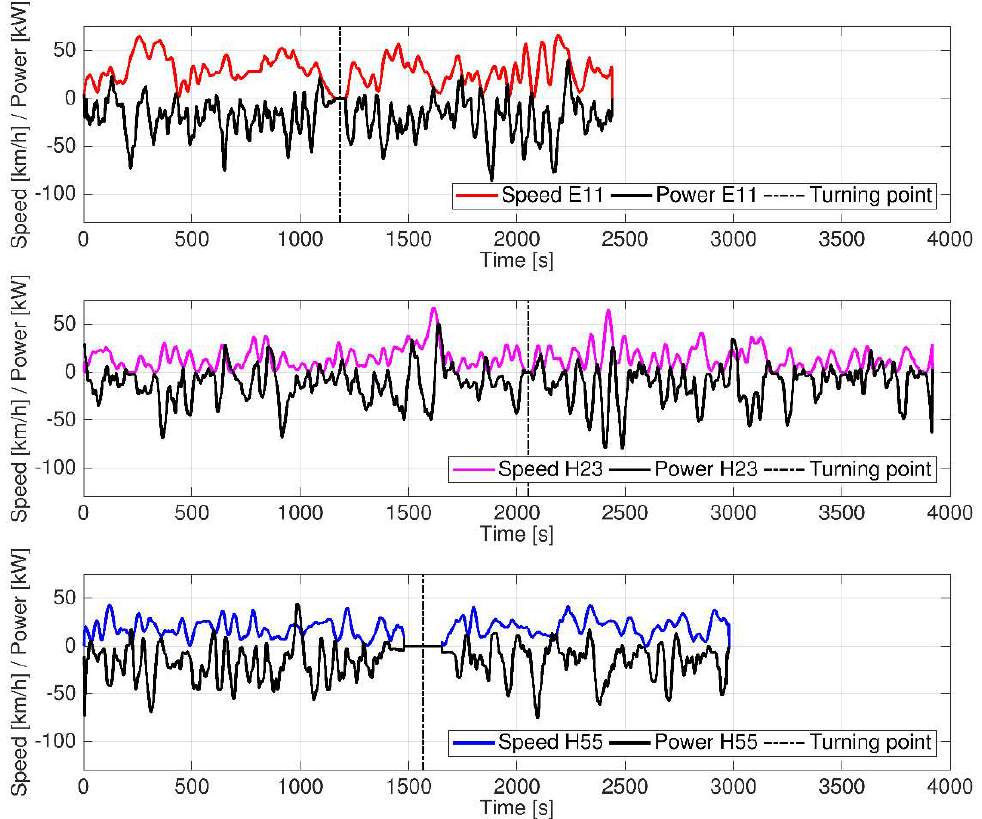
Figure 10. Speed and power profiles of the E11, H23, and H55 bus routes.